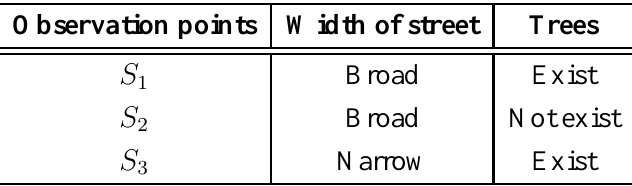
Table 6. Environmental characteristics of three observation